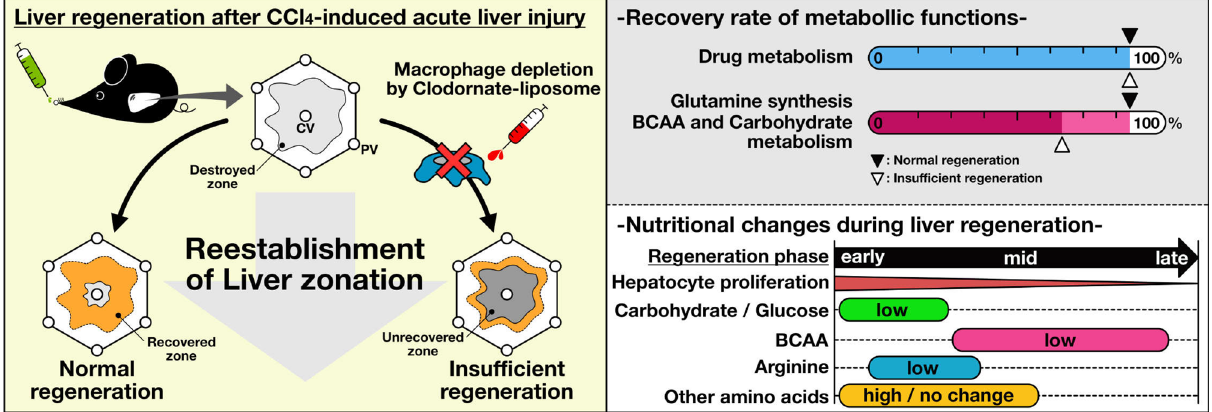
Figure 6. Overview of the study. Under normal conditions, liver macrophages remodel the injured liver tissues and promote recovery of liver metabolic functions during liver regeneration after acute liver injury. However, loss of macrophages causes insufficient tissue remodelling. Suppression of tissue remodelling is accompanied by defects in the recovery of amino acid and carbohydrate metabolism. However, drug metabolic functions retain regenerative capacity even if tissue remodelling is